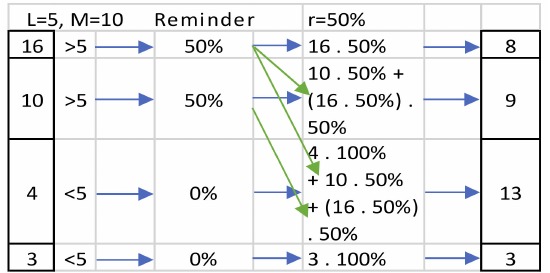
Figure 8. Water mass gain and loss values for reminder and noise factors are set to 50% [22]. The amount of water in a current frame (right-most column) is calcuated from the amount of water in a specific level (left-most column), plus water added from higher levels (blue arrows). The water residue level L=M*Reminder, and the noise level r are used to calcuate the amount of water